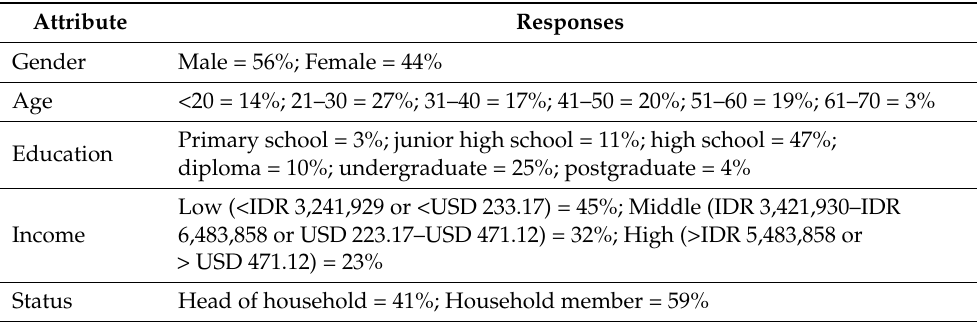
Table 1. Respondents’